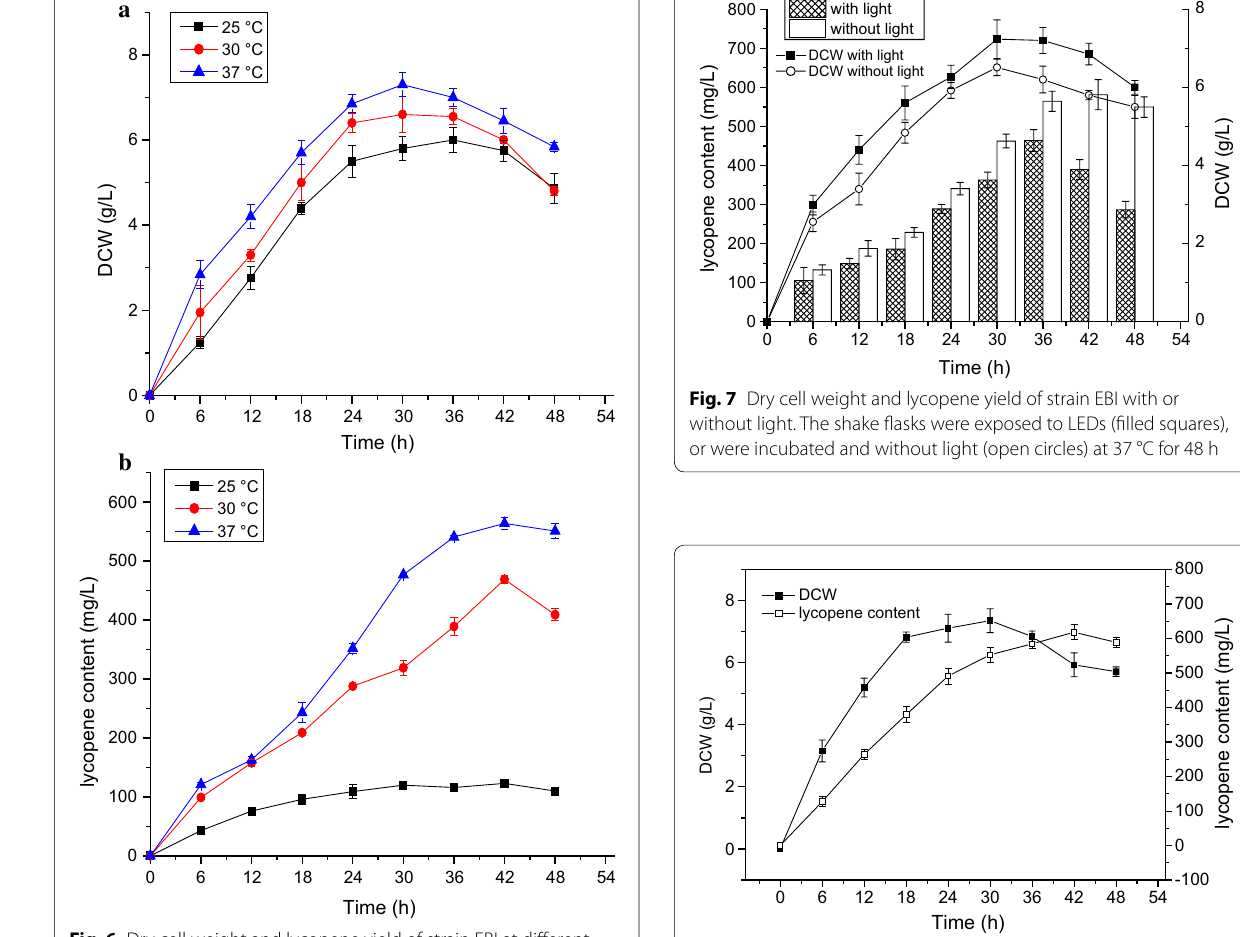
Fig. 6 Dry cell weight and lycopene yield of strain EBI at different Fig. 8 Dry cell weight and lycopene yield of strain EBI under temperatures. a Cell dry weight of EBI in 2 YT G medium (20 g L − 1 × + optimized conditions. Dry cell weight (filled squares) and lycopene glycerol) after growth at 25, 30, and 37 °C for 48 h. b Lycopene content (open squares) of the EBI strain under the optimal conditions production of EBI in 2 YT G medium (20 g L − 1 glycerol) after × + in shake flask culture. The values are the averages growth at 25, 30, and 37 °C for 48 h. The data represent the means deviations from three independent of three independent experiments. Error bars represent standard deviations